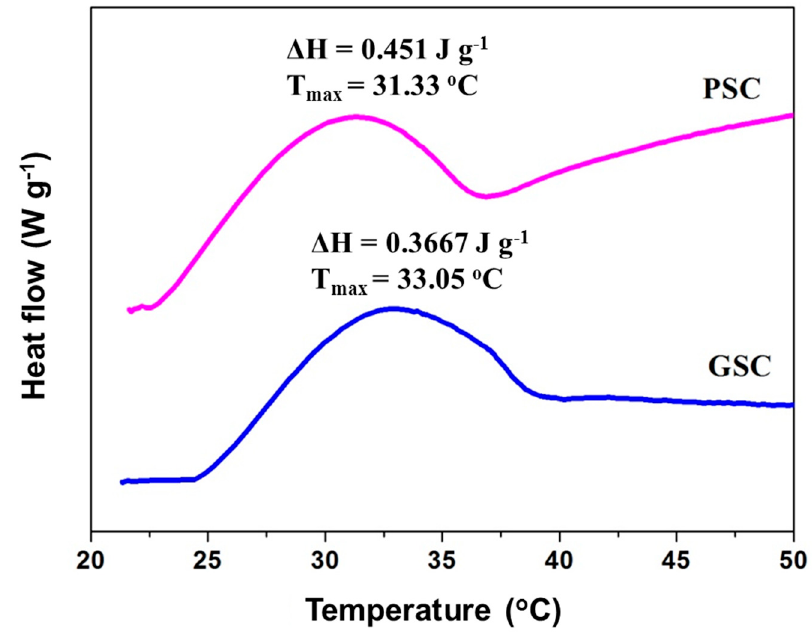
Figure 4. Differential scanning calorimetry (DSC) thermogram of GSC and PSC from surf clam shell ( Coelomactra antiquata ). ∆ H: denaturation enthalpy; T max : maximum transition temperature.